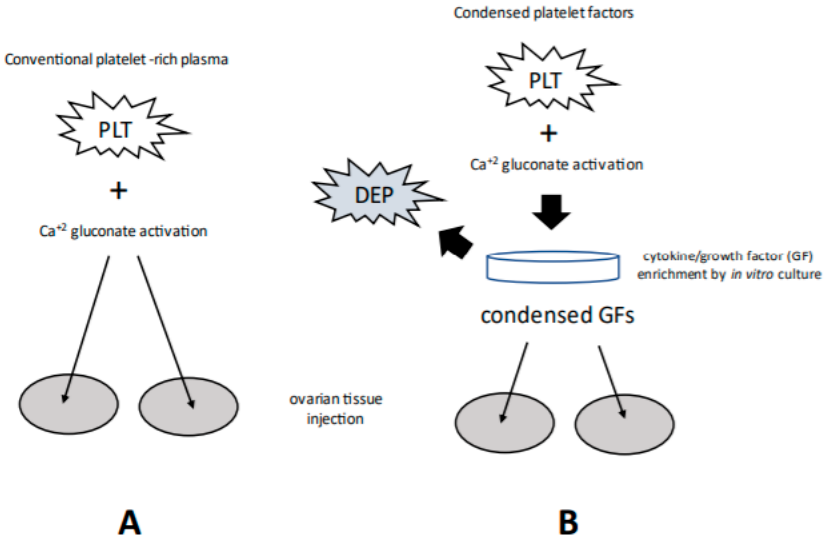
Figure 1. At least two methods of PRP sample preparation are currently in use, including conventional activation ( A ) and condensed cytokines isolated after in vitro platelet (PLT) incubation/processing ( B ). Note that depleted platelets (DEP) are removed (in B) following concentration of platelet releasate. Although bioactivity for both is a function of multiple signaling moieties, the concentration of such growth factors should be markedly increased along path B. Relevant platelet-derived cytokines include Vascular endothelial growth factor (VEGF), a signal protein promoting angiogenesis; Ligand of CD40 (CD-40L), an inflammatory signal for endothelium, platelets, and leukocytes; Interleukin-1 β (IL-1 β ), an inflammatory marker involved in cell growth, differentiation; Interleukin-8 (IL-8), which initiates angiogenesis, perfusion, and movement to injury/infection sites; PLT derived growth factor (PDGF), essential for vascular development, proliferation of fibroblasts, osteoblasts, tenocytes, vascular SMCs and mesenchymal stem cells; and PLT factor 4 (PF4), central in organizing platelet aggregation.